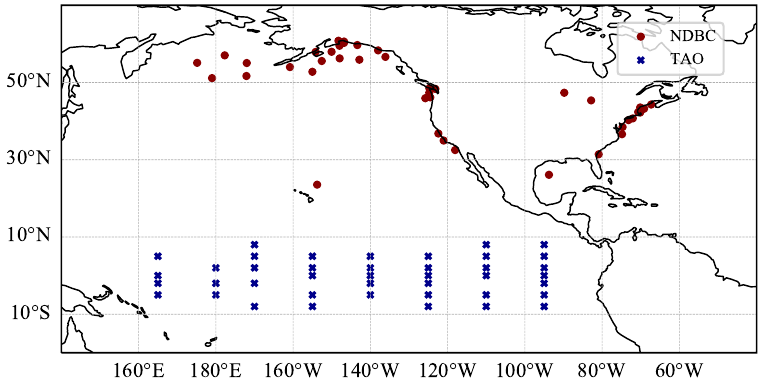
Figure 1. Locations of TAO (dark blue) and NDBC (dark red) buoys are used in this